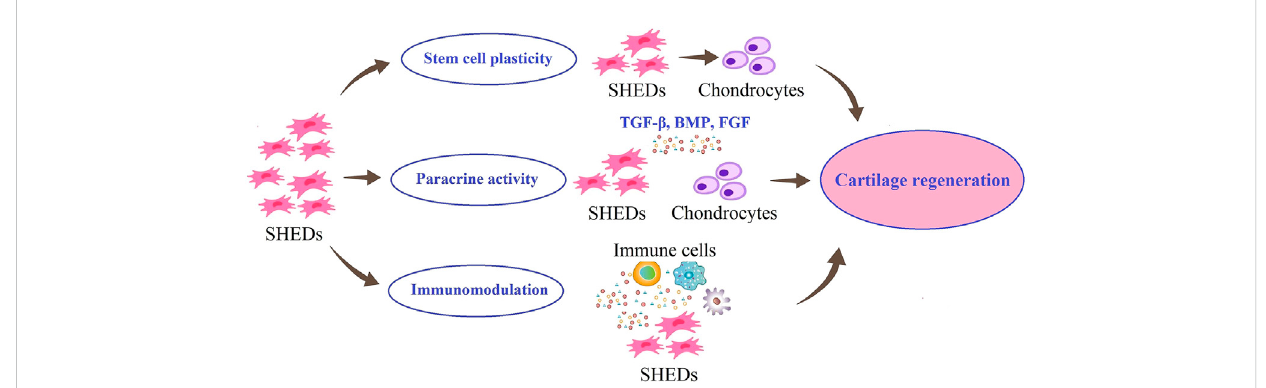
FIGURE 2 Possible roles of SHED in cartilage regeneration. SHED can proliferate and differentiate into chondrocytes. Also, SHED can secrete different growth factors, to maintain chondrocyte phenotypes and promote their proliferation. In addition, SHED have immunomodulatory effects on the lesion